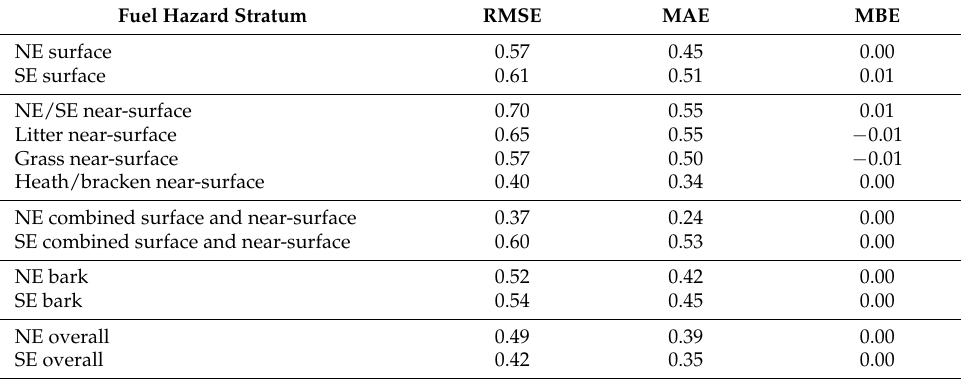
Table 9. Goodness-of-fit statistics for hazard rating